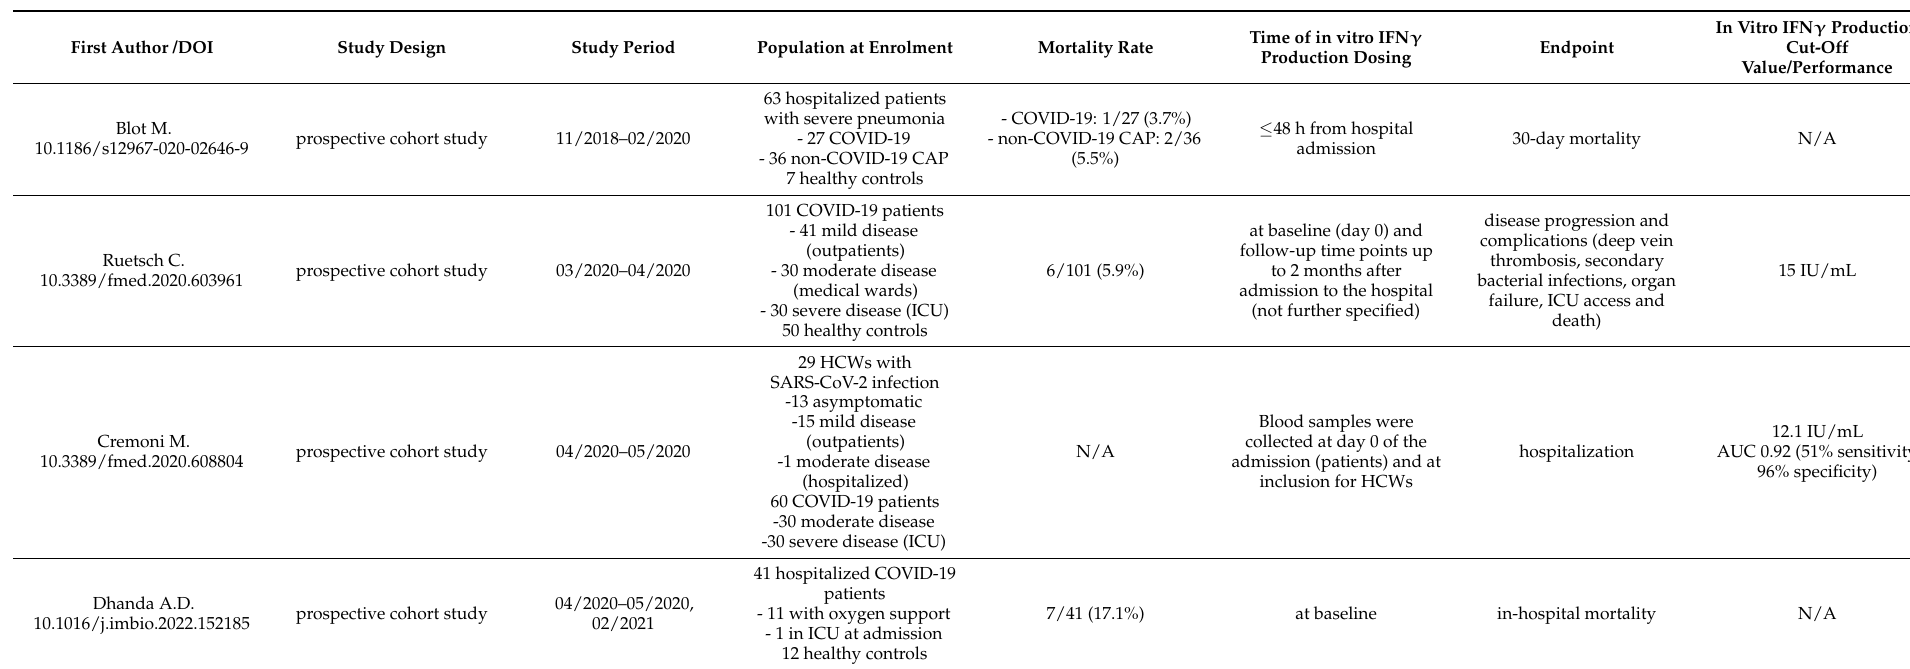
Table 4. Clinical studies investigating diagnostic and prognostic performance of in vitro IFN γ production in patients with SARS-CoV-2